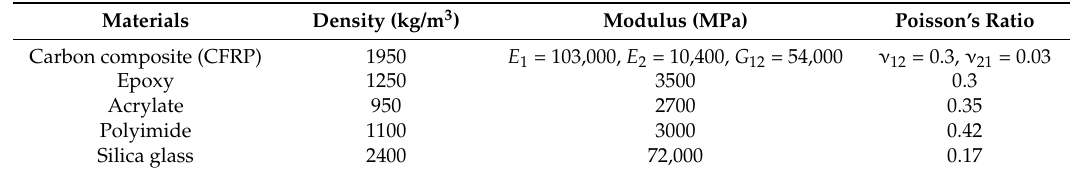
Table 1. Mechanical properties of the materials used [1]. Table 1 : Mechanical properties of the materials used [1].